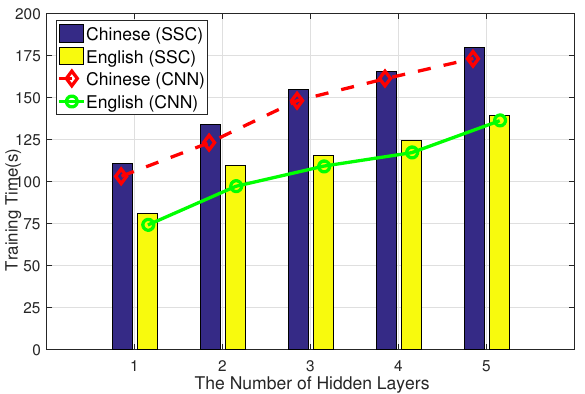
Figure 11. The training time on different numbers of hidden layers. SSC, semi-supervised